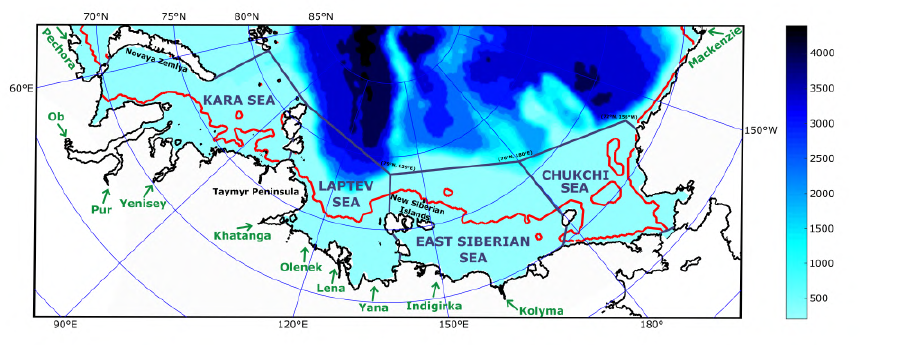
Figure 1. The map of the Siberian Arctic seas and the Arctic rivers. Colors represent the Arctic Ocean bathymetry (in m) [25]; red line shows the isobath of 45 m. The borders of the seas was taken from